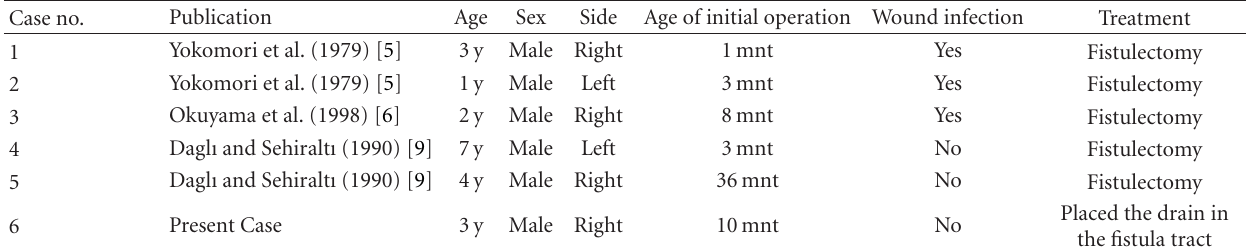
Table 1: The cases of acquired umbilical fistula after repair of inguinal hernia with the present case. Case no.